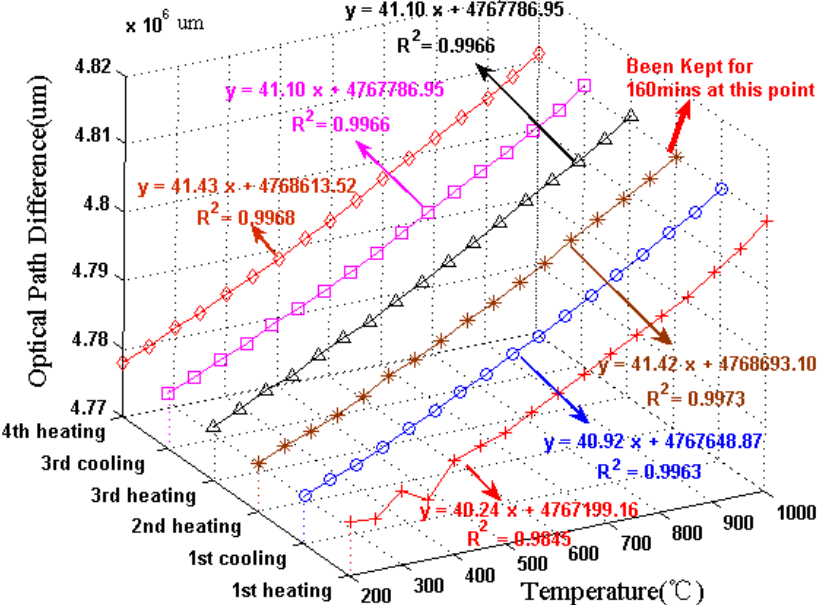
Figure 2. Measured reflection spectra of the FPI at different temperatures.